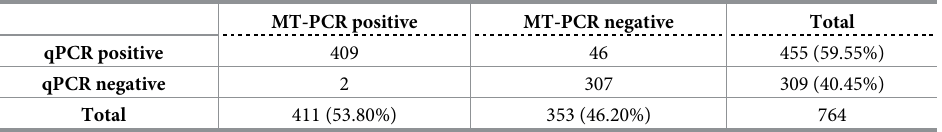
Table 1. 2x2 contingency table for any STH infections. Any STH infections is defined as a positive infection by molecular diagnostic analysis with one or more STH